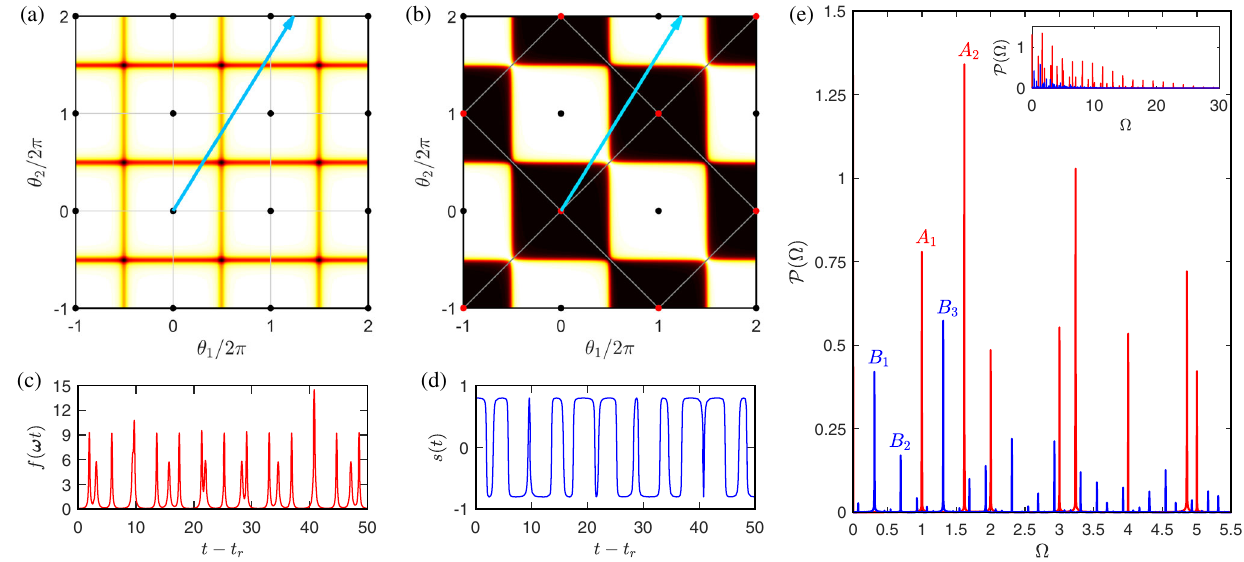
FIG. 4. Z 2 DTQC of Sec. IV B: Driving function (a,c) and time-quasicrystal response (b,d). The spontaneous symmetry breaking of time-translation symmetries as seen in the power spectrum (e) of a local observable. (a) Driving function f ð θ Þ in extended θ space, with Δ ð θ Þ in Eq. (31) replaced by Δ θ Þ in Eq. (35) with N ¼ 20 . The function is symmetric under translations τ ∈ L ¼ 2 π Z 2 (black points). N ð Grey boxes represent the unit cell that is the standard torus. The blue arrow is the single time trajectory θ ¼ ω t . (b) In contrast, the ρ ð θ Þ(cid:3) is symmetric under translations by τ 0 ¼ 2 π ð 1 ; (cid:5) 1 Þ Z , which defines a symmetry-breaking sublattice observable s ð θ Þ ¼ Tr ½ σ z i L L 0 (red points). The grey boxes represent the unit cell, which is enlarged and rotated by 45° with respect to the driving SSB ¼ Hamiltonian ’ s unit cell. (c) Driving profile f ð t Þ ¼ f ð ω t Þ as a smooth function in the time domain. Times are measured from the ∼ J − 1 . (d) Discrete time quasicrystal response s ð t Þ ¼ s ð ω t Þ in the time domain. (e) Power spectra P ð Ω Þ of both the relaxation time t r driving function f ð t Þ (red) and the observable s ð t Þ (blue). The power spectrum of f ð t Þ exhibits peaks at the base frequencies Ω ¼ n · ω , with dominant peaks at Ω ¼ ω 1 ( A 1 ) and Ω ¼ ω 2 ( A 2 ). The power spectrum of s ð t Þ has peaks instead at frequencies shifted from the base frequencies by fractional values, reflecting the spontaneous breaking of the time-translation symmetries of the driving Hamiltonian. In particular, the dominant peaks are at Ω ¼ ð ω 2 − ω 1 Þ = 2 ( B 1 ), Ω ¼ ω 2 − ω 1 ( B 2 ), and Ω ¼ ð ω 1 þ ω 2 Þ = 2 ( B 3 ). The inset shows the power spectra over a wider range of